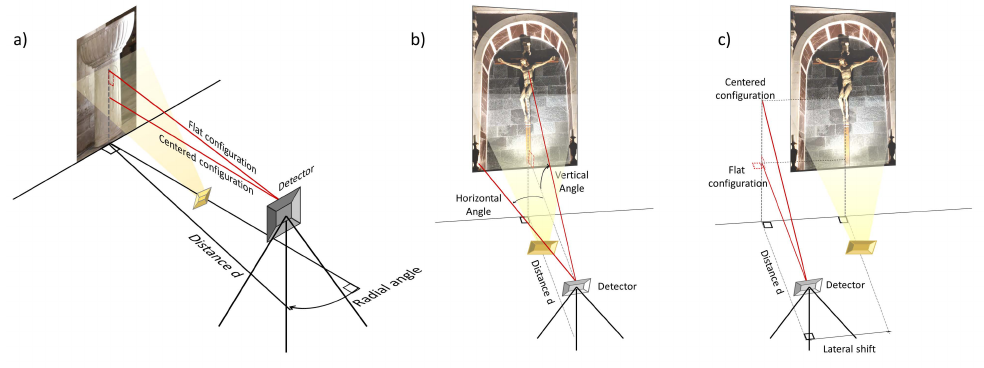
Figure 3. Layout for SNR and PER measurements (see text): ( a ) polar, ( b ) FoV, ( c ) lateral displacement. Measurements are performed on different experimental grids for the two artworks, in order to emulate realistic visitors position and view angles in the allowed observation